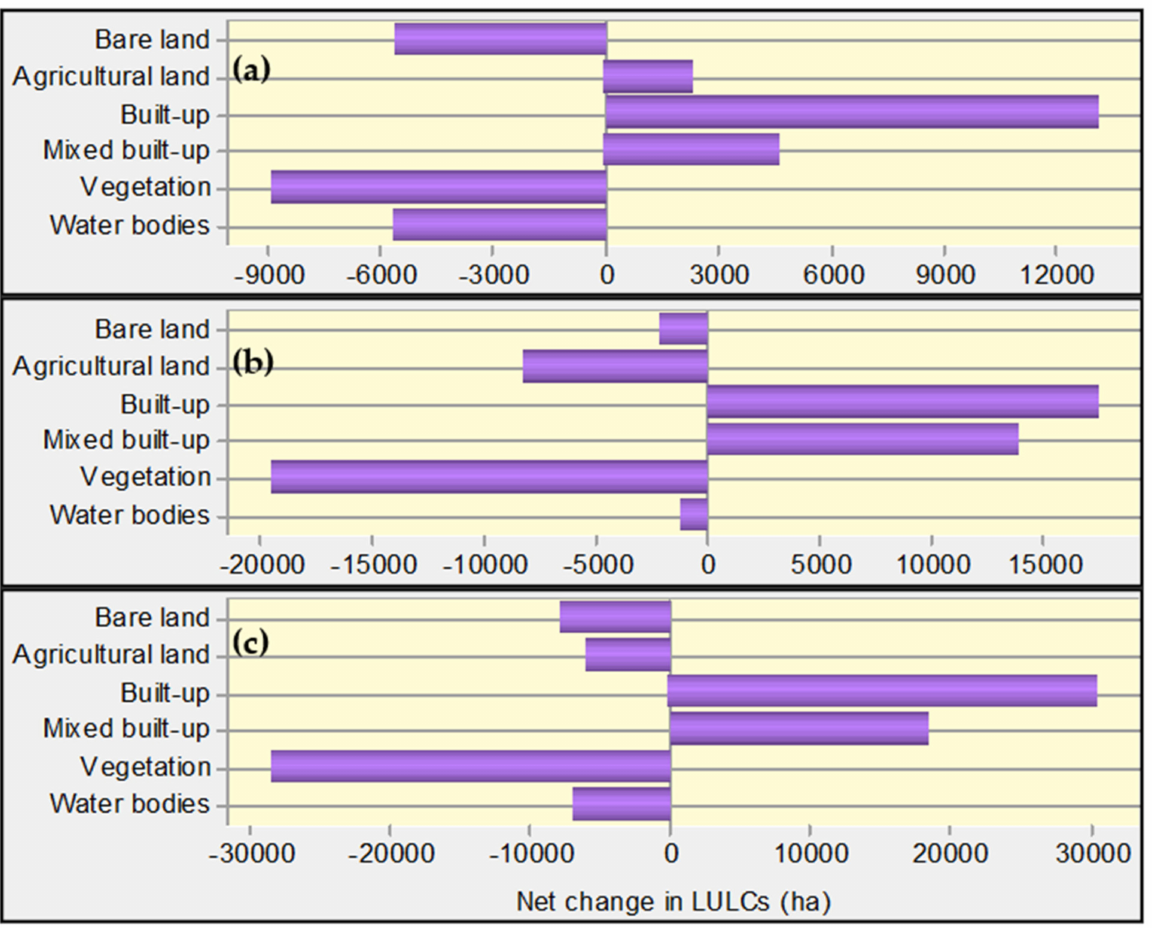
Figure 7. Magnitude of net change (ha) in the LULCs of KMA; ( a ) net change between 1996 and 2006, ( b ) net change between 2006 and 2016, and ( c ) net change between 1996 and